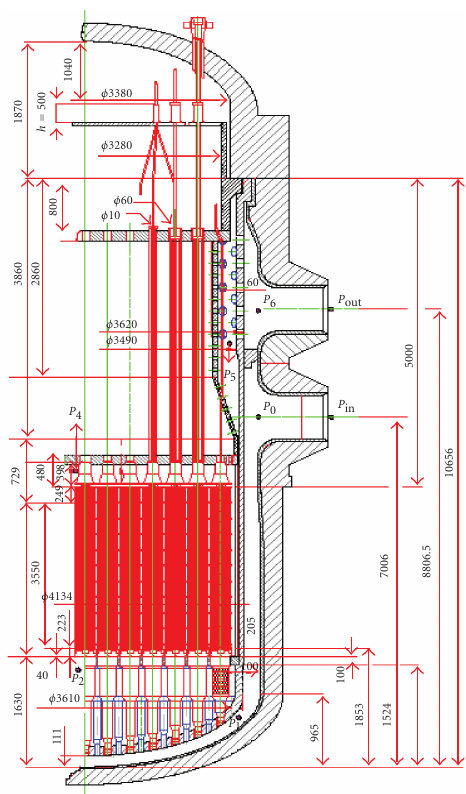
Figure 1: The RPV of the VVER-1000 reactor with the constructive peculiarities.